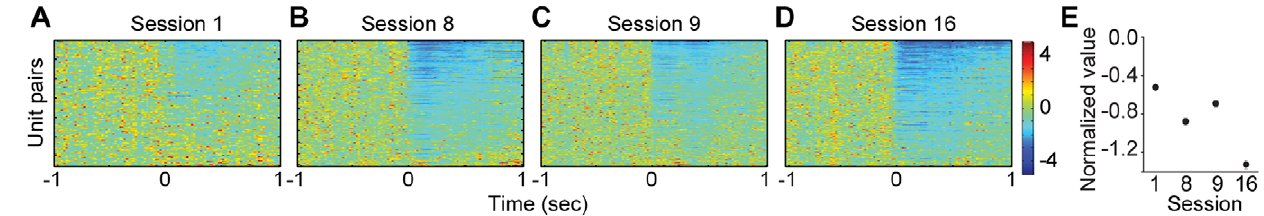
Figure 3. Baseline normalized information ratio ( IR ). ( A–D ) The change in IR aligned to CS onset. Data are depicted as mean IR in each time bin according to the color scale at the right. Each row represents one simultaneously recorded VTA unit pair. The data are sorted by post-stimulus normalized IR value. Each VTA unit pair is depicted in session 1 ( A ), 8 ( B ), 9 ( C ) and 16 ( D ). Note 1) the abrupt onset of the effect and 2) the uniformity of the effect, which increases dramatically from early to later sessions. (E) Mean information ratio of pairs of simultaneously recorded VTA units. Data are depicted as mean 6 SEM and baseline normalized to 0 for sessions 1, 8, 9 and 16.